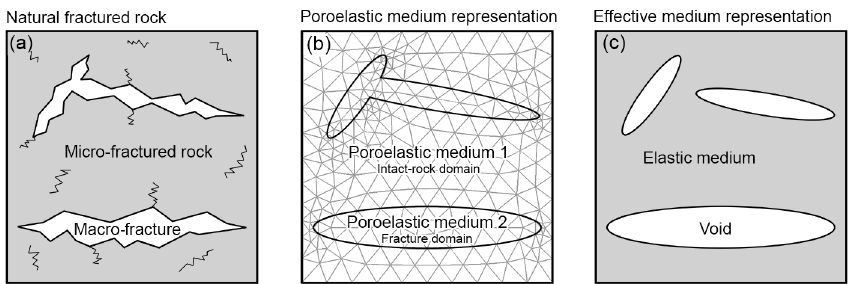
Figure 1. Comparison of natural rock with its conceptual representations. (a) Natural fractured rock with microscopic and macroscopic fractures of complex shape. (b) Poroelastic medium representation, where intersecting macro-fractures and the background medium are both parameterized as isotropic poroelastic media on a finite-element grid. (c) Effective medium representation, consisting of well-separated macroscopic elliptic voids embedded into an isotropic elastic medium.